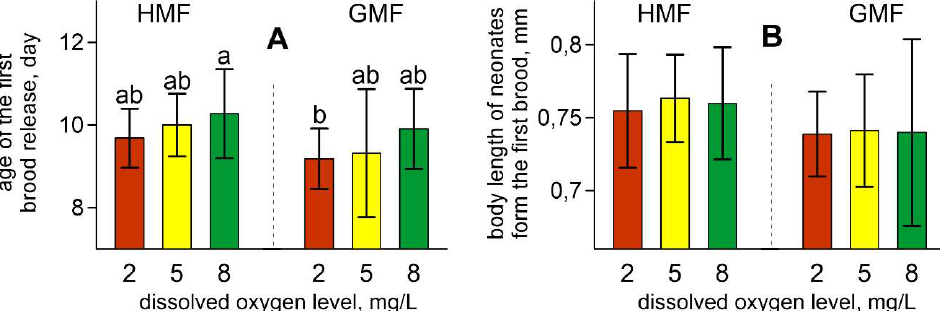
Figure 1. Age of the first brood release ( A ) and newborns’ body length ( B ) in studied groups of daphnids. Values are means ± standard deviation. Different letters indicate significant differences among groups ( p < 0.05) after Kruskal–Wallis test and Dunn’s post-hoc test. For all variables with the same letters, the difference between the groups is not statistically significant. Significantly different groups have different letters.